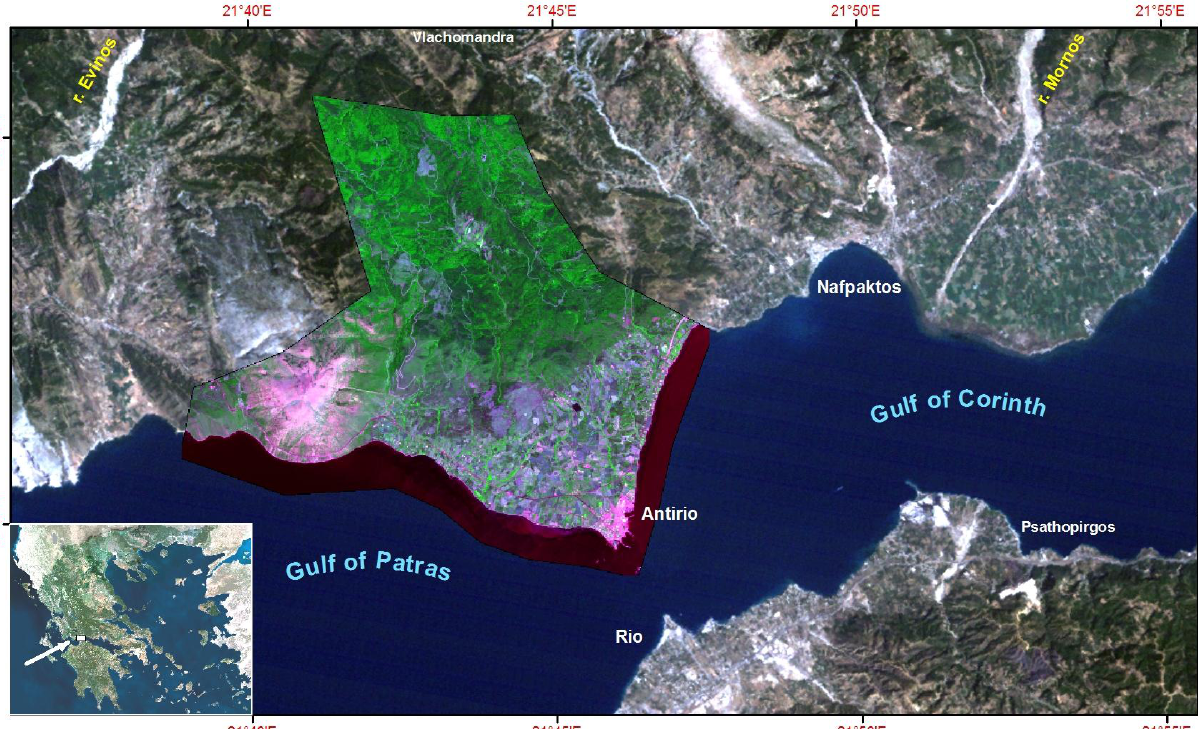
Figure 1. The study area on a natural color (3,2,1—R,G,B) reference image acquired by Landsat 5 on September 2, 1992. The Quickbird image used in this study (1,4,3—R,G,B) is shown as a partially overlapping layer. The white rectangle in the inset shows the location of the study